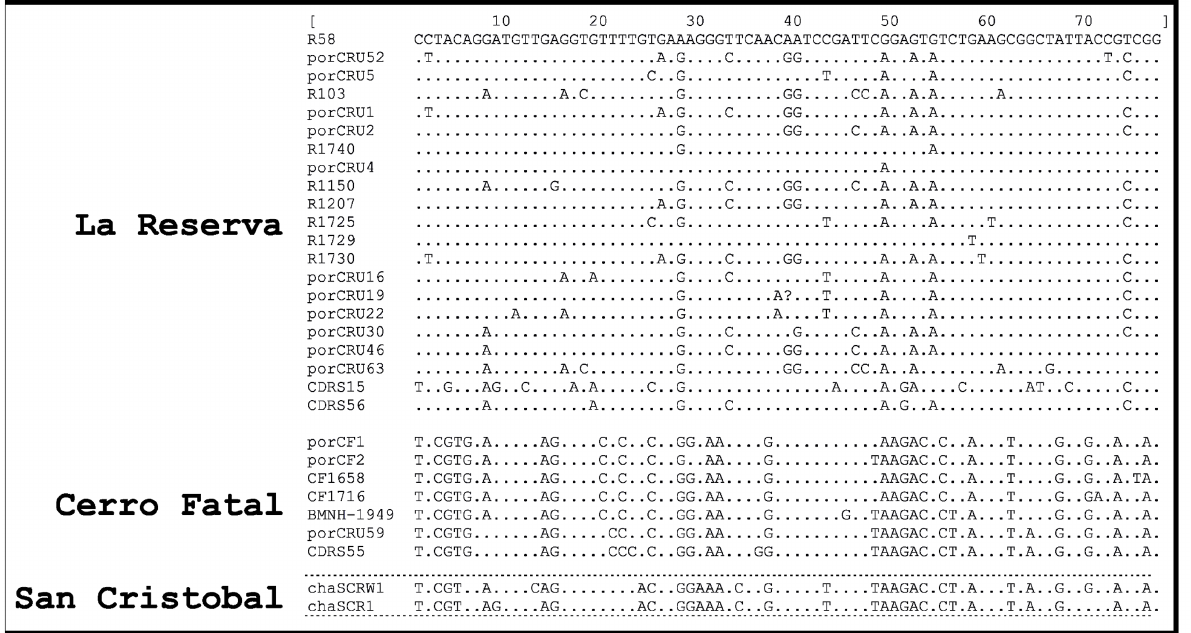
Fig 3. Polymorphic sites between Chelonoidis sp. nov. (Cerro Fatal — Santa Cruz), C . chathamensis (San Cristóbal), and C . porteri (Reserva — Santa Cruz). The position of diagnostic locations is relative to the Genbank record AY956622 for porCF1 from Cerro Fatal. - = gap position and K = G/T polymorphism.